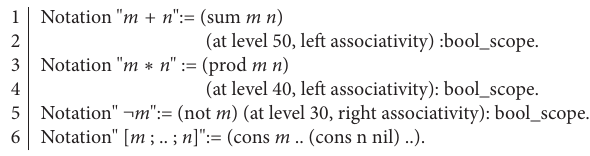
Figure 7: Shorthand notations.